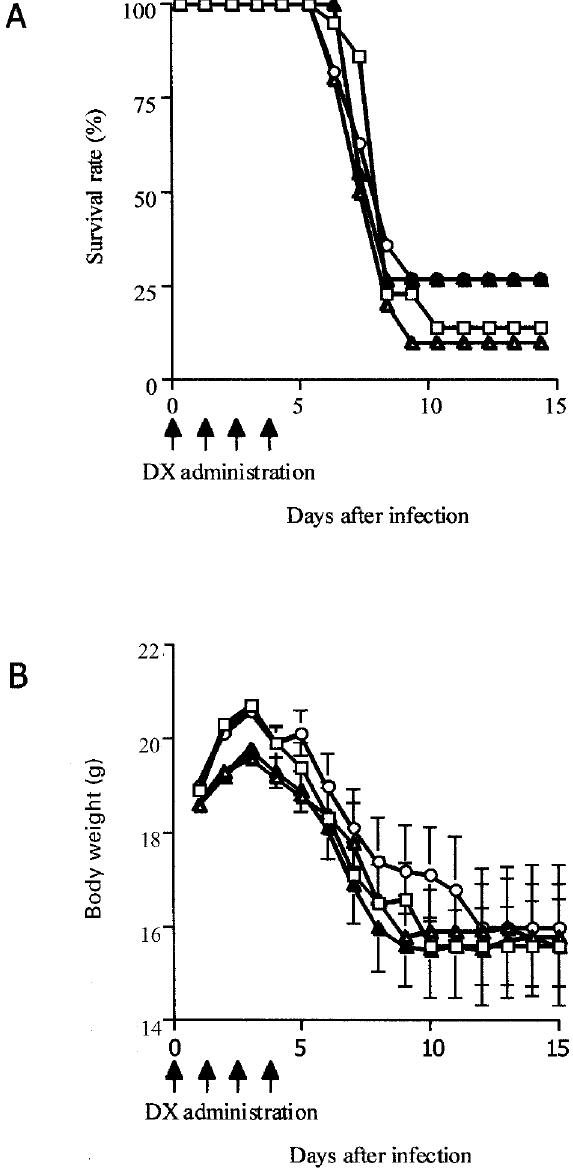
FIG. 2. Effect of dexamethasone (DX) administration on the survival rate of influenza virus-infected mice. DX was administrated intrapenitonealy at doses of 4.0mg/day (filled circle), 0.4mg/day (open circle) and 0.04mg/day (open triangle) once daily during the initial 4 days (0–3 days after infection). As a control (open square), phosphate-buffered saline was given in the same manner. The data from 10 to 11 mice in each group were assessed by Fisher’s exact probabil- ity test. (B) Effect of DX administration on body weight loss of influenza virus-infected mice. The changes in body weight of the infected mice in each group shown (A) were monitored daily and are expressed as the mean ± SE (error bar) using the same symbols as (A). The data were assessed by unpaired t